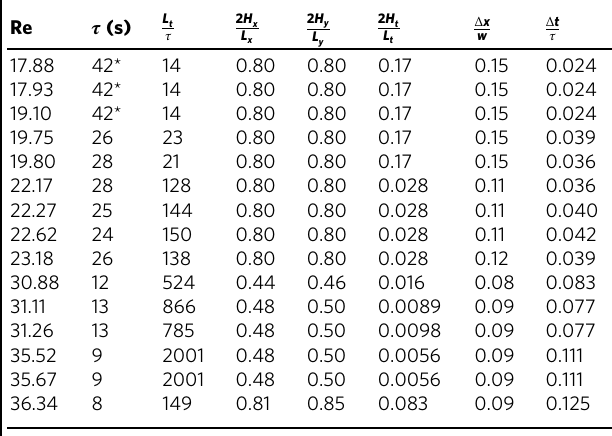
Table 1 Description of the data sets used for the symbolic regression